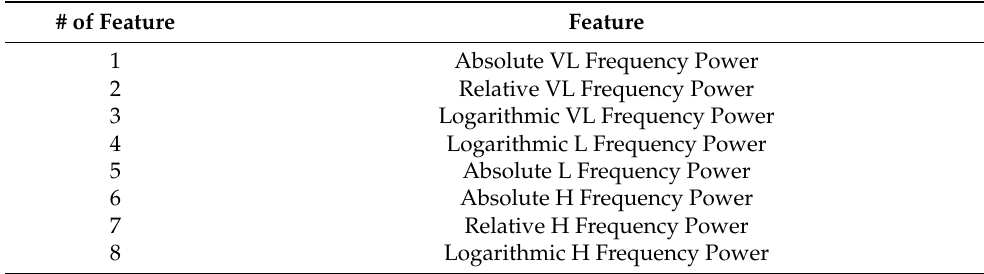
Table 8. Significant features in frequency-domain using the autoregressive